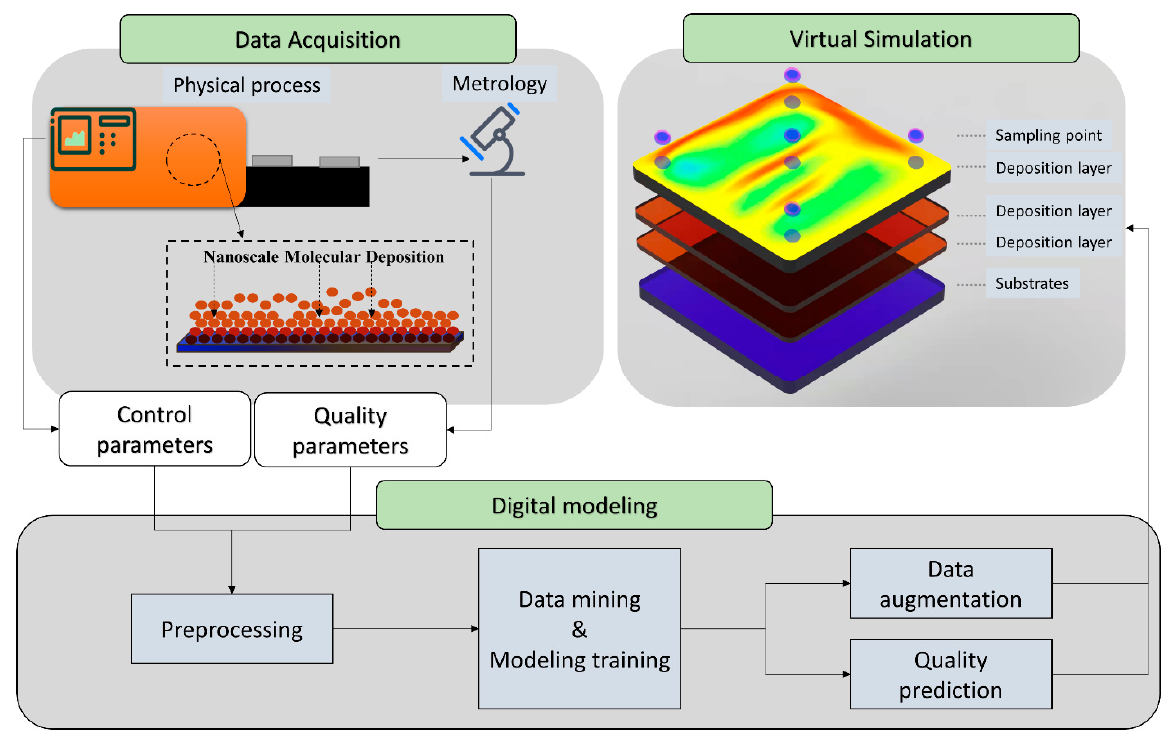
Figure 5. Schematic diagram of practical application in NCM